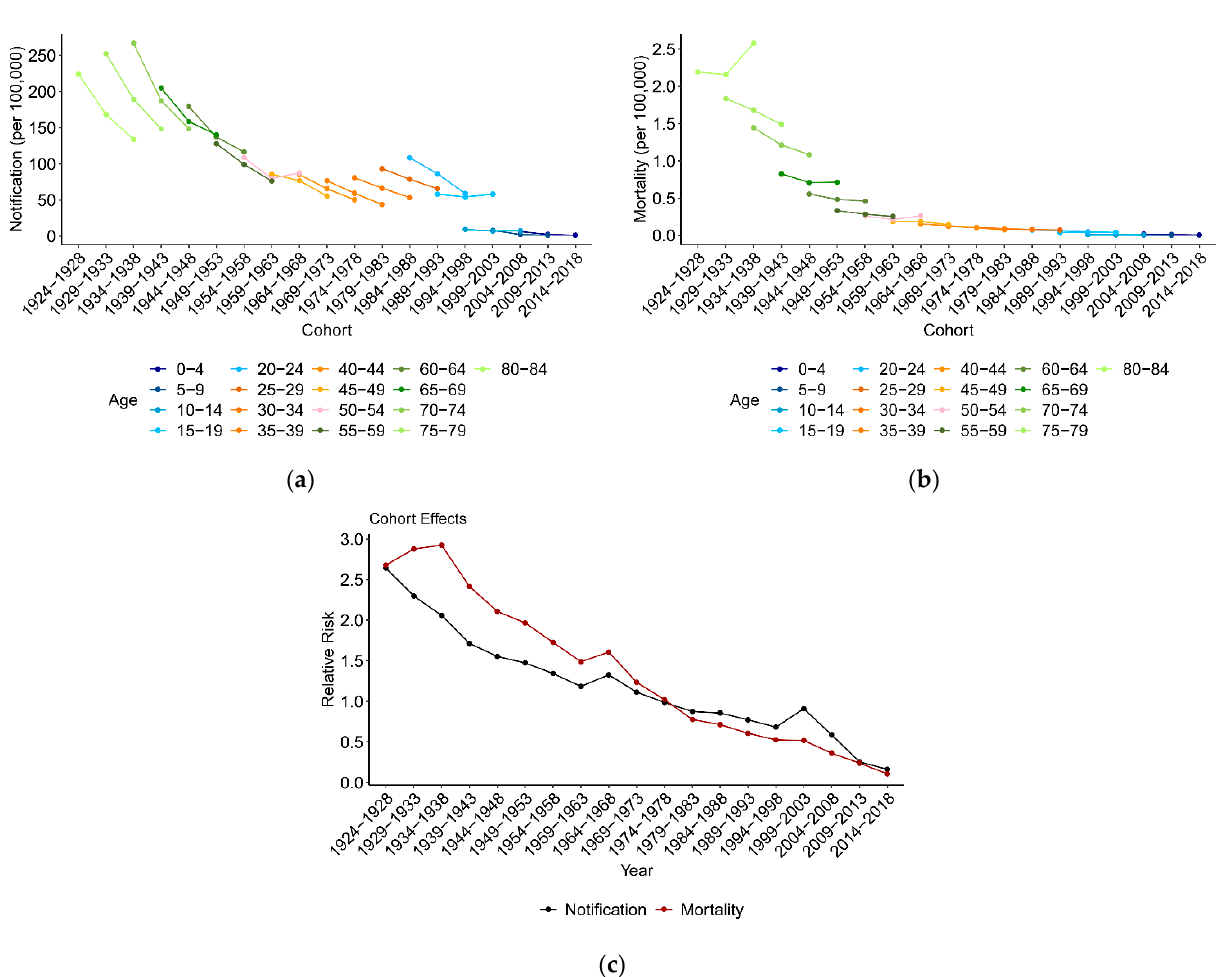
Figure 4. TB notification and mortality variation with birth cohorts between 2004 and 2018, and the cohort effects on TB notification and mortality. ( a ) TB notification variation with cohorts. ( b ) TB mortality variation with cohorts. ( c ) Cohort effects.